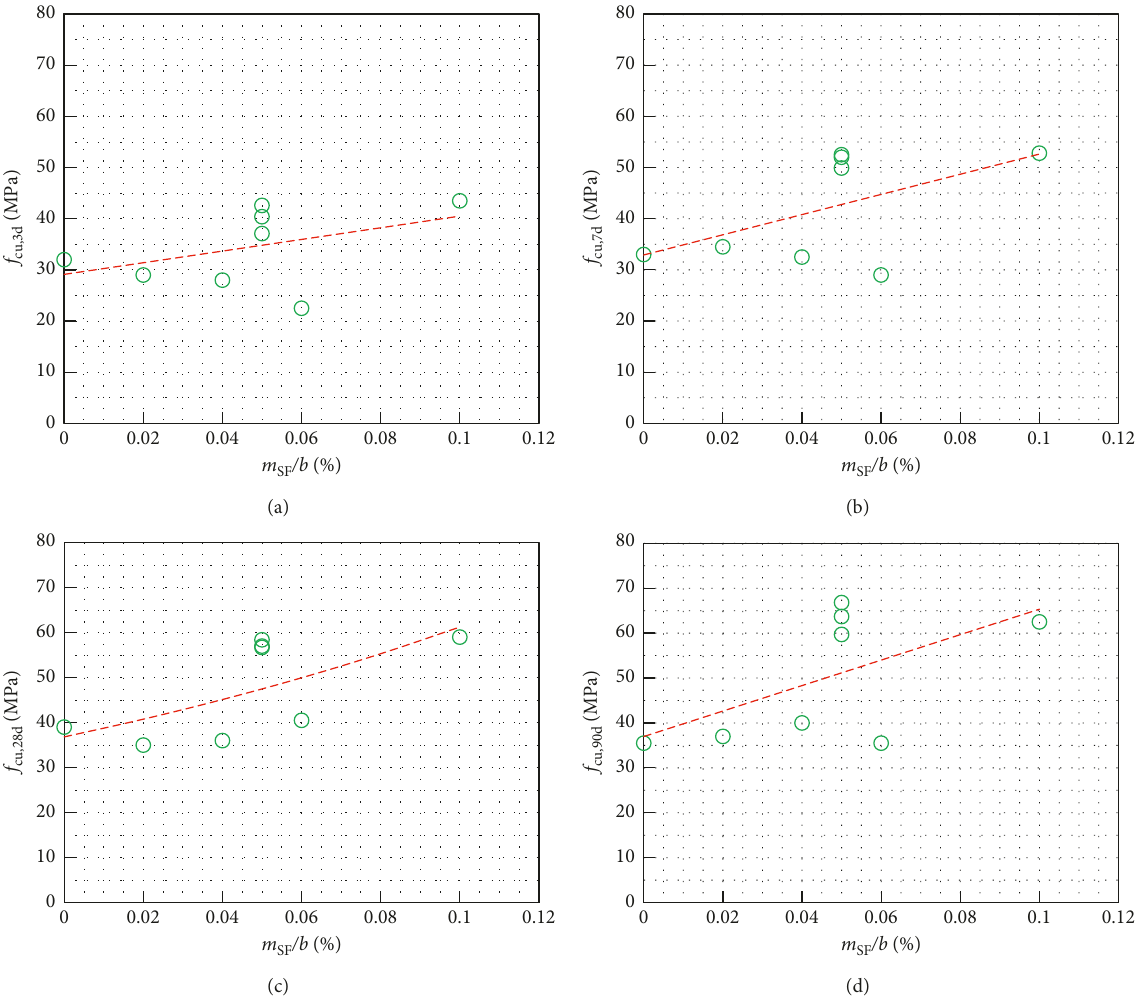
Figure 10: Effect of (m) SF /(b) on (f) cu,N . (a) At 3 days. (b) At 7 days. (c) At 28 days. (d) At 90 days.